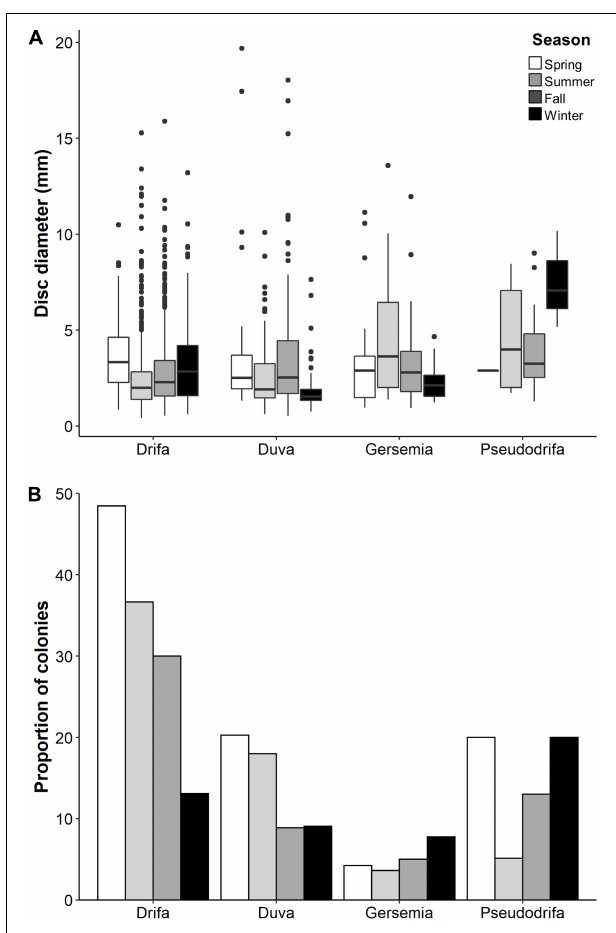
FIGURE 5 | (A) Basket star disc diameter by taxa (shown as genus) per season. (B) Relative proportion of colonies with basket stars per season and host species (number of colonies with basket stars relative to total number of colonies available per season). Pseudodrifa racemosa winter is represented by one colony.